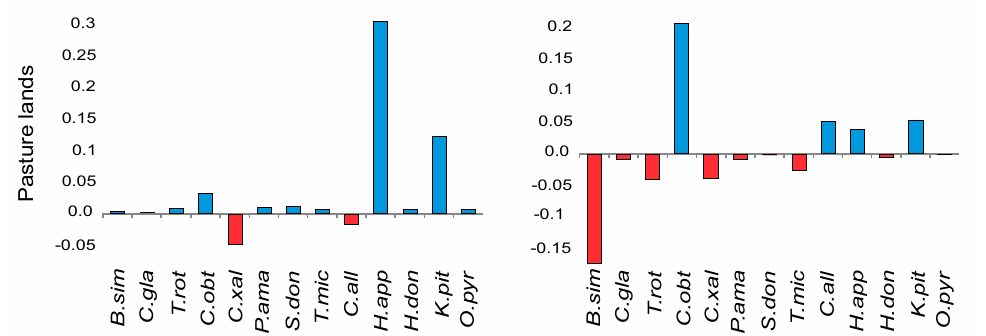
Figure 5. Differences between the presence and the density-weighted index in three different habitats. Positive values (blue) indicate that the density-weighted index showed higher limitation than the presence index. Negative values (red) indicate that less limitation was estimated by the density-weighted index. Acronyms refer to the first letter of the genus and the three first letters of the species (full species names are included in Table A1).